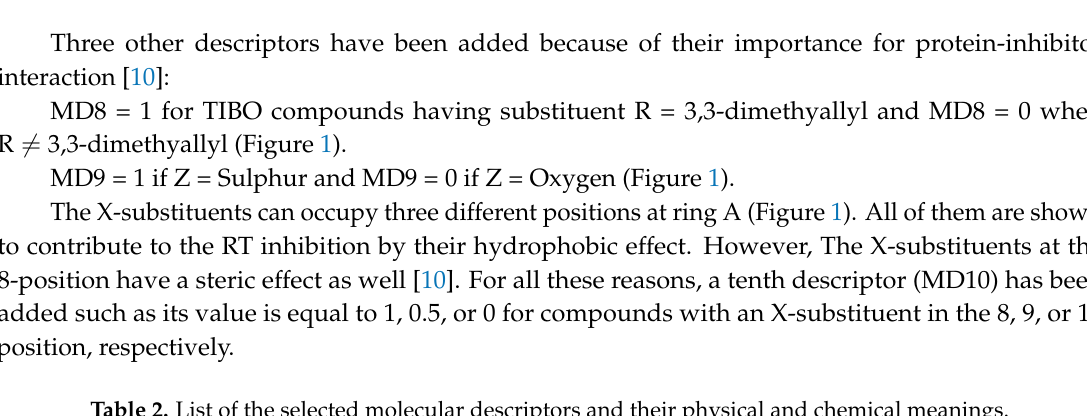
Table 2. List of the selected molecular descriptors and their physical and chemical